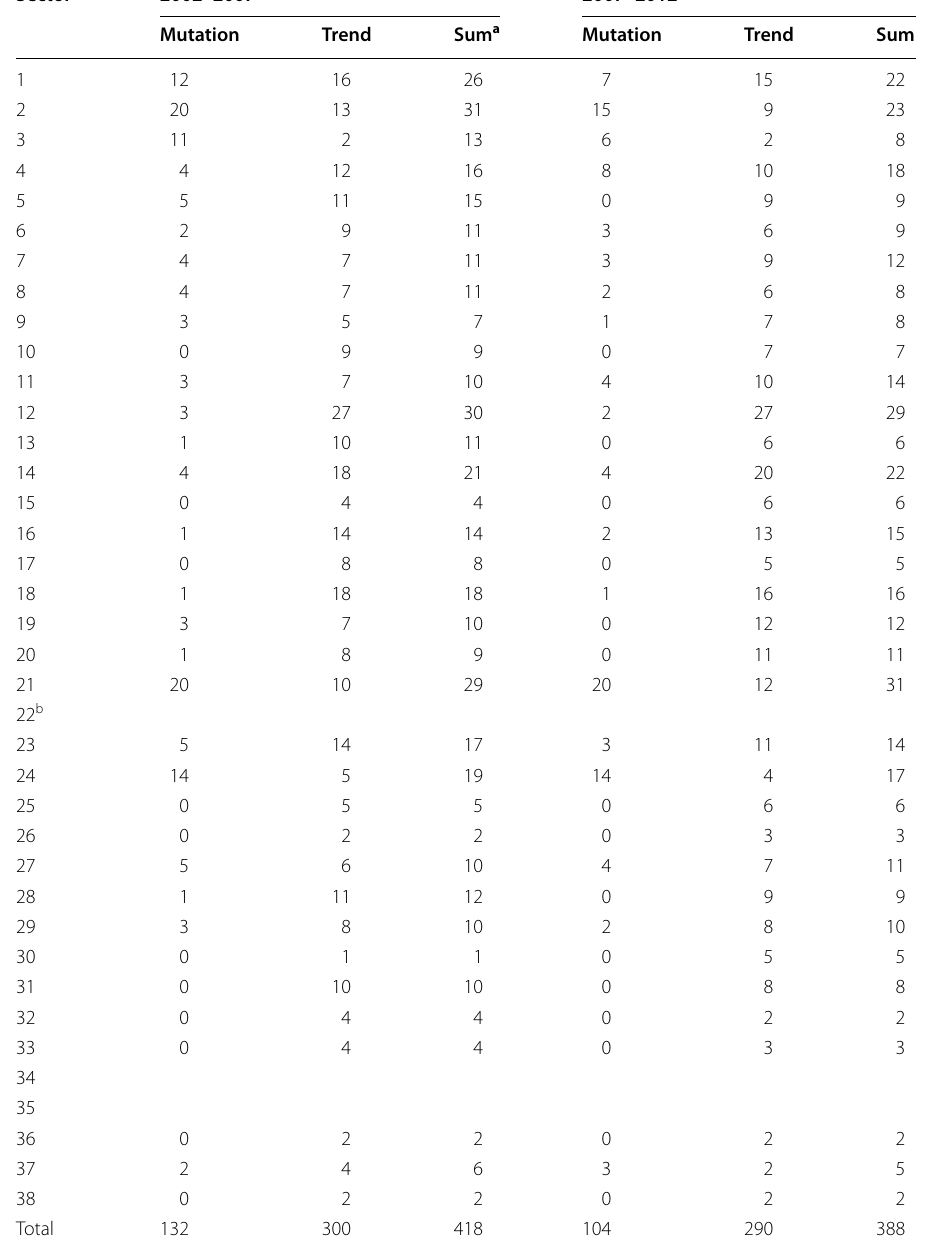
Table 12 Aberrant KC indicators summed by